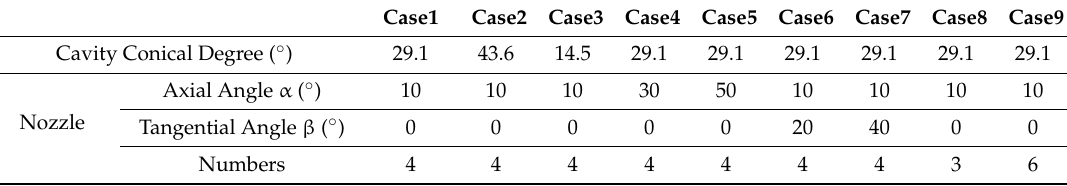
Table 1. Characteristics of the investigated geometries.